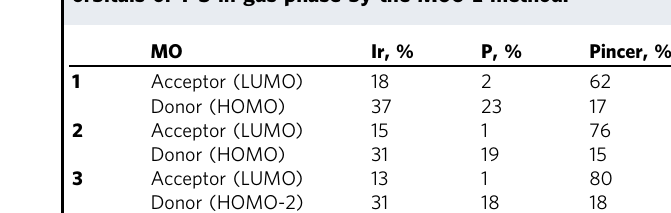
Table 2 Composition of donor and acceptor molecular orbitals of 1 – 3 in gas phase by the M06-L